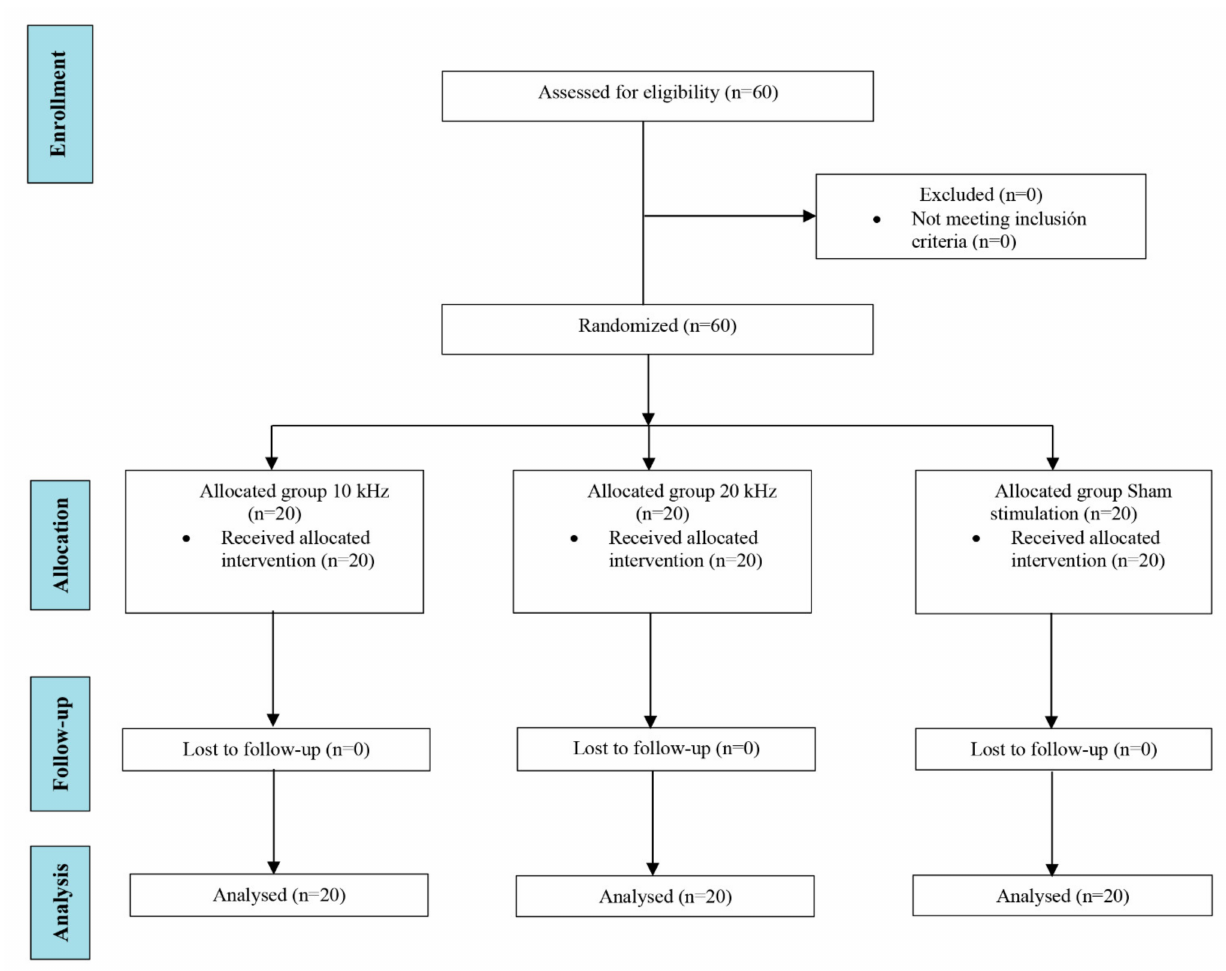
Figure 2. Flowchart showing the process and stages of a parallel randomized clinical trial following CONSORT guidelines. Table 1. Demographic characteristics of participants at baseline. Statistical test: ( a ) one-way